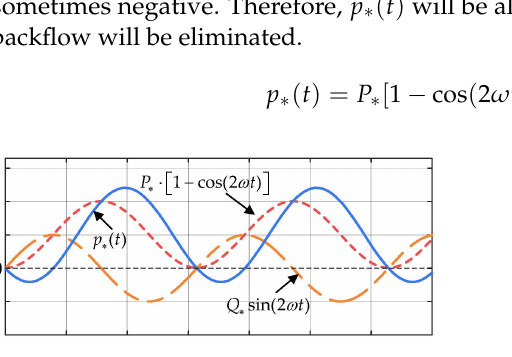
Figure 4. The relationship between backflow power and reactive